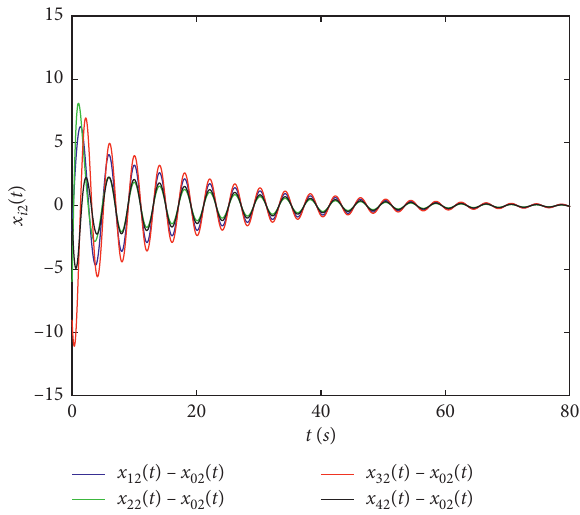
Figure 10: The 2nd state error trajectory of each agent under protocol